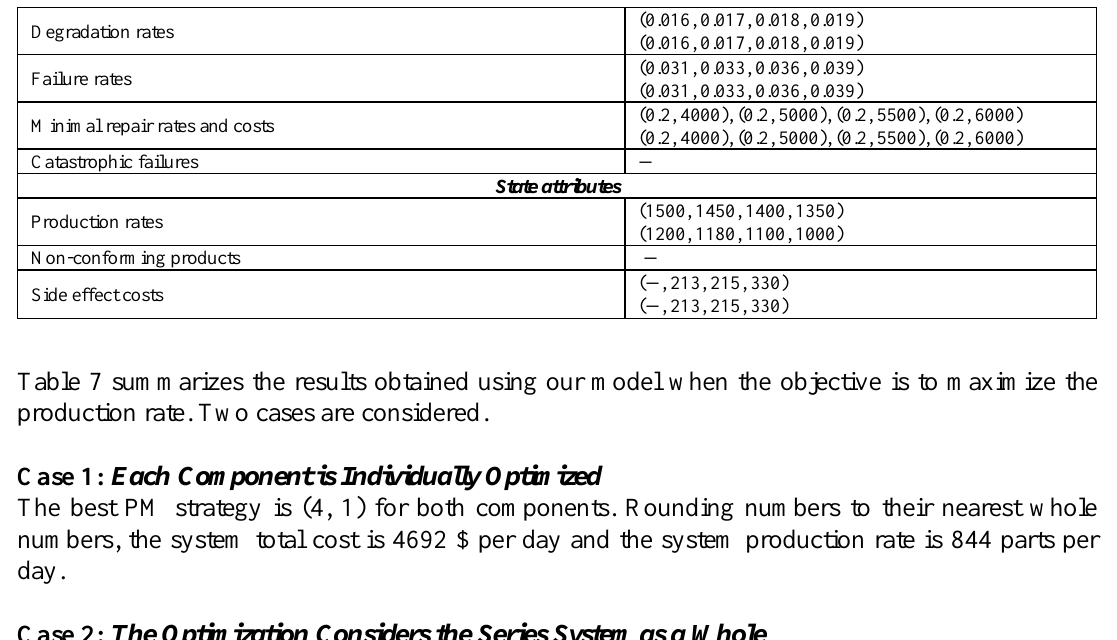
Table 6. Input data of the two components in the series